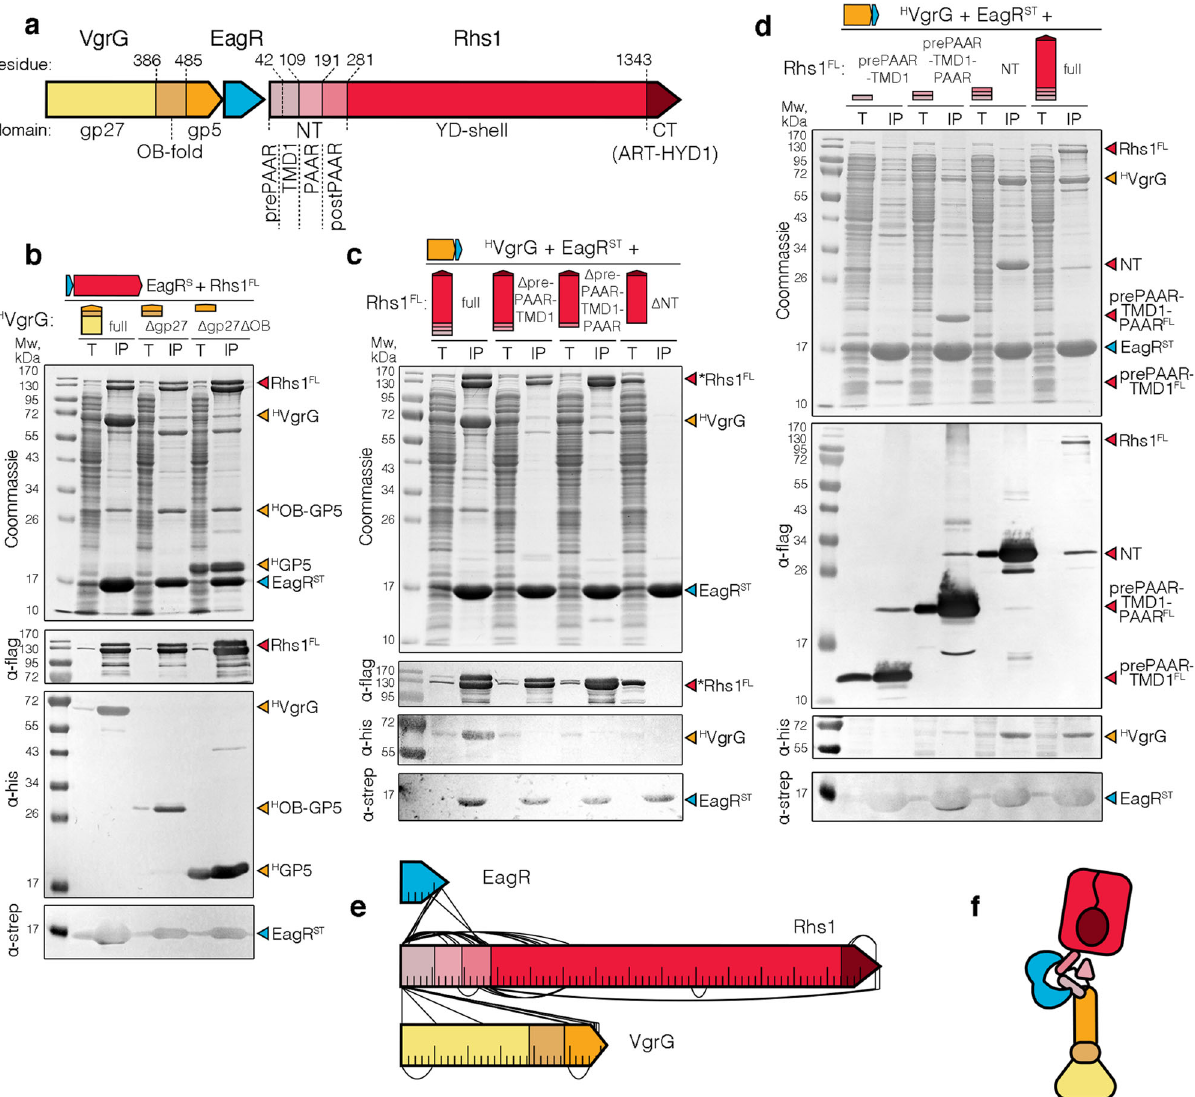
Fig. 2 Architecture and contact map of the VgrG-Rhs1-EagR complex. a Schematic representations of Photorhabdus laumondii VgrG and Rhs1 proteins. The protein domains are indicated, as well as their boundaries. b – d Pull-down assays. Total cell extracts (T) from E. coli BL21(DE3) cells producing Strep-tagged EagR ( ST EagR), FLAG-tagged Rhs1 (Rhs1 FL ) with His 6 -tagged VgrG ( H VgrG) truncated variants ( b ) or His 6 -tagged VgrG ( H VgrG), Strep-tagged EagR ( ST EagR) with FLAG-tagged Rhs1 (Rhs1 FL ) truncated variants ( c and d ) were subjected to puri fi cation on streptactin-agarose beads. Strep-tagged and co- precipitated proteins were eluted with desthiobiotin (IP). Total and IP fractions were analyzed by SDS-PAGE and co-puri fi ed proteins were stained by Coomassie blue (upper panel) or immunodetected using anti-His, anti-Strep, and anti-FLAG antibodies (lower panels). Molecular weight markers (Mw, in kDa) are indicated on the left. Pull-down assays have been performed at least in triplicate, and a representative experiment is shown. e Schematic representation of intermolecular and intramolecular contacts between the EagR, Rhs1, and VgrG proteins identi fi ed by cross-link mass spectrometry. For clarity reasons, only the contacts that have minimal distance of 50 amino acids are shown. All cross-linked peptides are listed in Supplementary Table 1, and a map with all the contacts is shown as Supplementary Fig. 5. f Schematic model of the Photorhabdus laumondii VgrG (shades of orange)-EagR (blue)- Rhs1 (shades of red) complex architecture based on pull-down and cross-link mass spectrometry